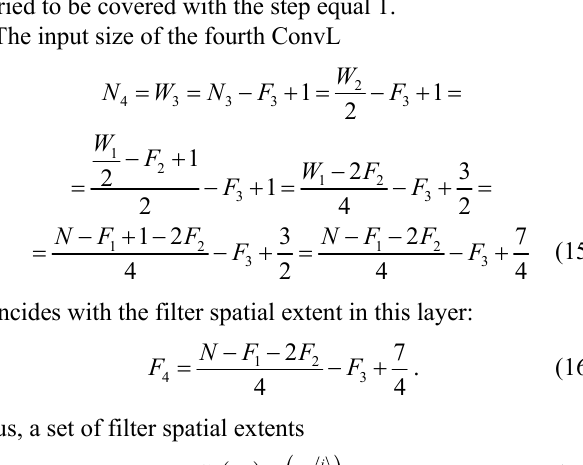
Fig. 2. Total number of possible filter spatial extents against the size of input images. The number increases having some semblance of an exponential law.